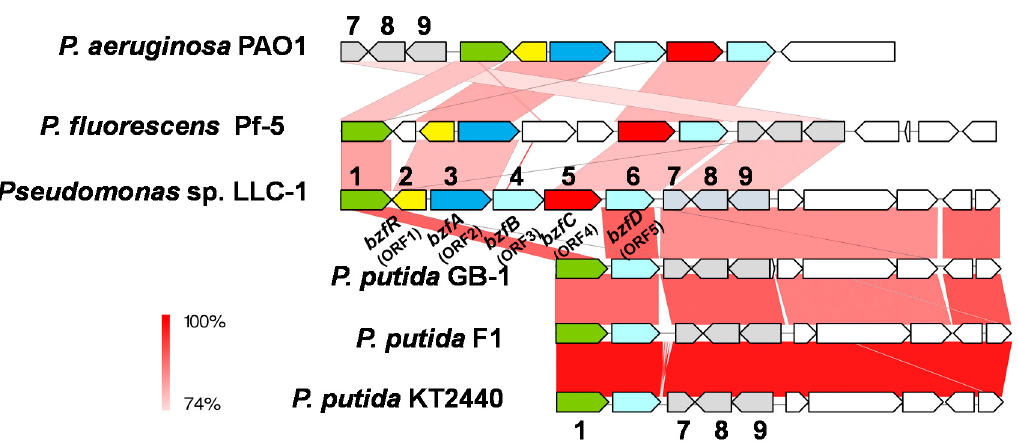
Figure 2. Physical map of benzoylformate catabolic bzf gene cluster and vanillate cetabolic van operon of Pseudomoas sp. strain LLC-1 and other pseudomonas strains. 1, vanK ; 2, bzfR (ORF1); 3, bzfA (ORF2); 4, bzfB (ORF3); 5, bzfC (ORF4); 6, bzfD (ORF5); 7, vanR ; 8, vanA ; 9, vanB ;. ORFs with conserved sequence (>70% identity with those of LLC-1 within bzf gene cluster or van operon) are filled with the same color. The shading in pink to red shows the identity (74–100%) of the gene clusters as indicated on the left of the figure.